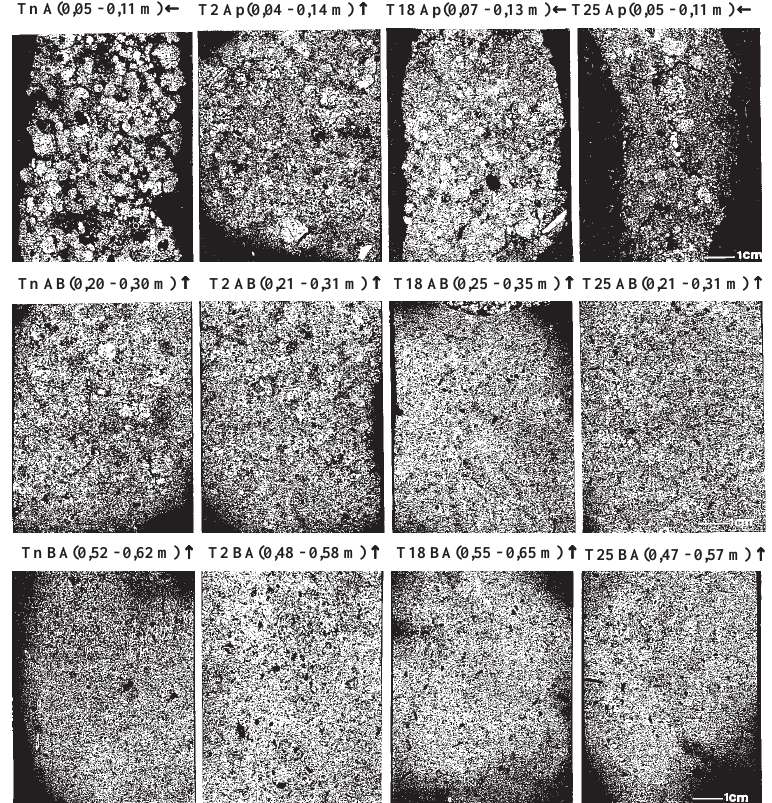
Figura 1. Aspecto macroscópico da porosidade dos horizontes Ap e subsuperficiais dos perfis sob cultivo (T2, T18 e T25) em relação aos horizontes A e subsuperficiais do perfil sob mata nativa